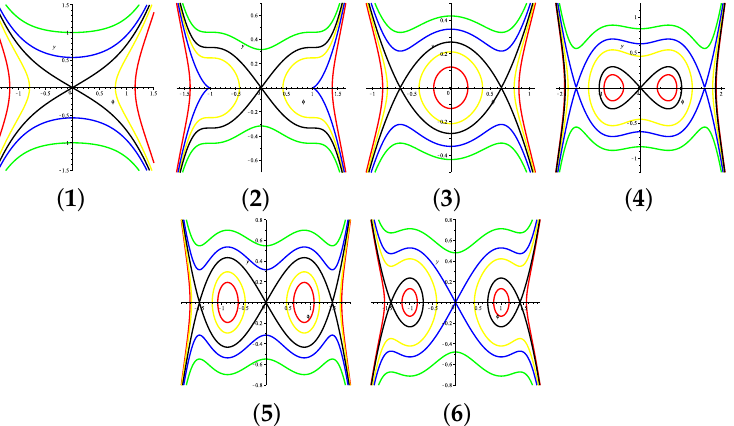
Figure 2. Phase portraits corresponding to system (5) under c > 0, α − 2 β = 0, a − 2 α < 0. ( 1 ) ∆ <